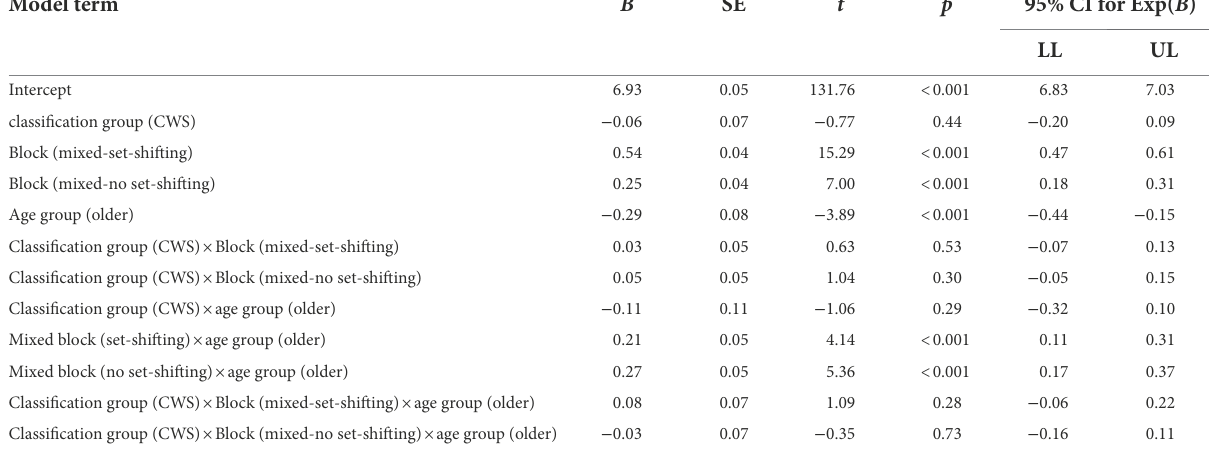
TABLE 2 Fixed effects of classification group, age group and block on response times (compatible trials analysis). Model